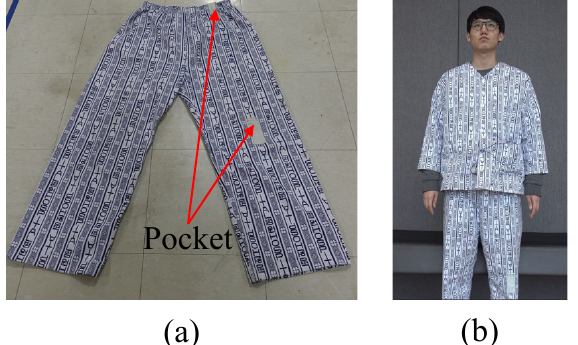
Figure 3. Pictures of the ( a ) patient pants with two pockets for the flexible sensors and ( b ) patient wearing the sensing